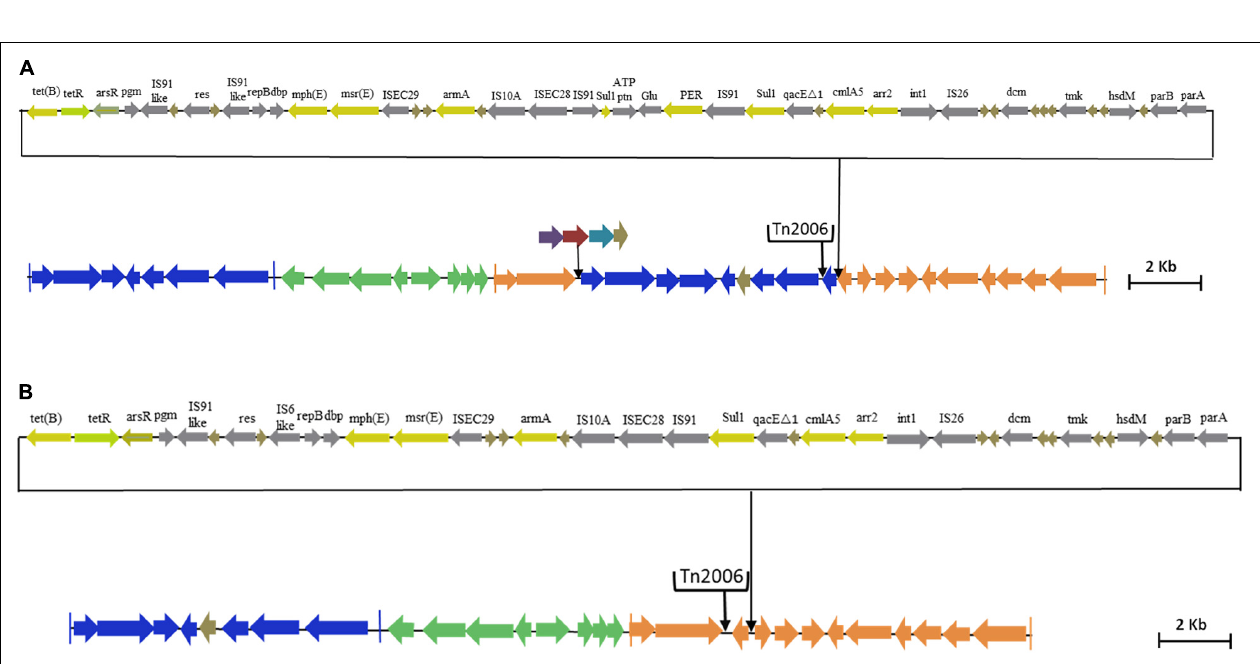
FIGURE 5 | (A) Genetic backbone of AB13 carrying AbGRI variant identified in this study. The Tn 6022 or Tn 6022 -derived part is shown in blue, the Tn 6172 part or its partial segments are shown in orange, and the linker region is shown in green. The black arrows in the downward direction indicate the insertion of IS element, transposon, or additional genes. The pale yellow arrow indicates AMR genes, the light green arrow represents the tetracycline repressor gene, the gray arrow represents insertion elements, and the brown arrow indicates hypothetical protein. (B) Genetic backbone of AB02 carrying AbGRI variant identified in this study. The Tn 6022 or Tn 6022 -derived part is shown in blue, the Tn 6172 part or its partial segments are shown in orange, and the linker region is shown in green. The black arrows shown downward indicate the insertion of IS element or transposon or additional genes. The pale yellow arrow indicates AMR genes, the light green arrow represents the tetracycline repressor gene, the gray arrow represents insertion elements, and the brown arrow indicates hypothetical protein.